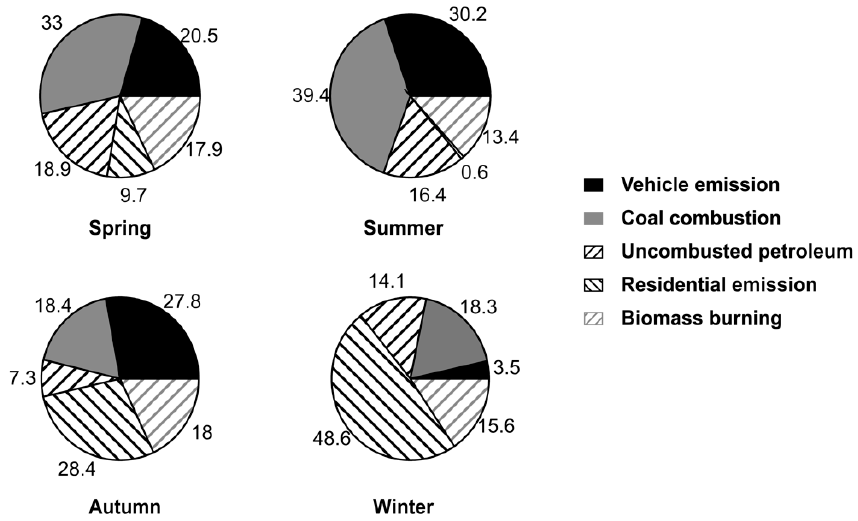
Figure 7. Contributions of the five sources to the total PAHs in PM 10 of Xi’an over four seasons.